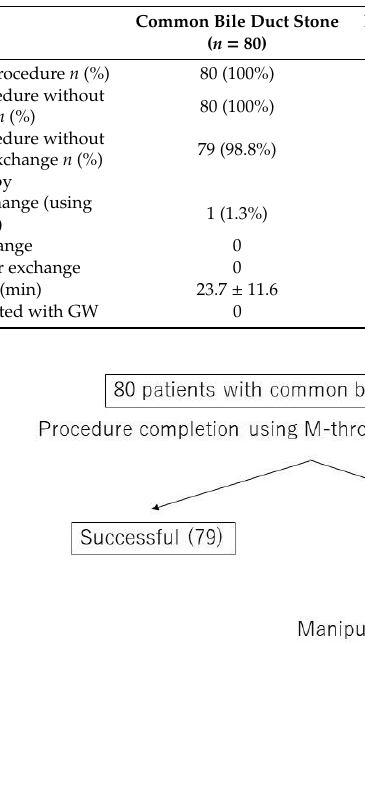
Table 2. Details of procedure outcomes.